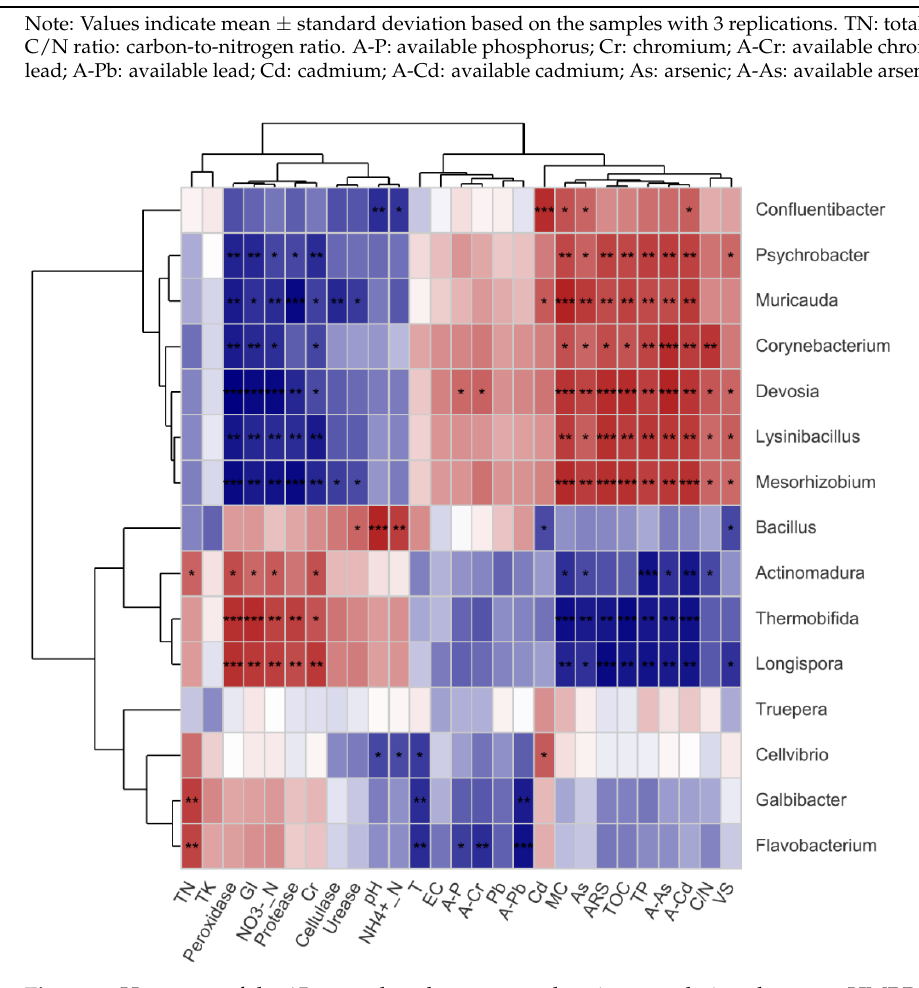
Figure 5. Heat map of the 15 most abundant genera showing correlations between HMRB bacterial community and environmental factors, enzyme activity, and heavy metals. Vertical: bacterial infor- mation; horizontal: selected factors. The left and acroscopic cluster tree reflect species and factors, respectively. Different colors indicate different correlation coefficients (r). “*” p < 0.05, “**” p < 0.01, and “***” p < 0.001. T: temperature; EC: electrical conductivity; GI: germination index; TOC: total organic carbon; TN: total nitrogen; C/N ratio: carbon-to-nitrogen ratio. TK: total potassium; TP: phosphorus; A-P: available phosphorus; Cr: chromium; A-Cr: available chromium; Pb: lead; A-Pb: available lead; Cd: cadmium; A-Cd: available cadmium; As: arsenic; A-As: available arsenic; ARS: arylsulfatase.